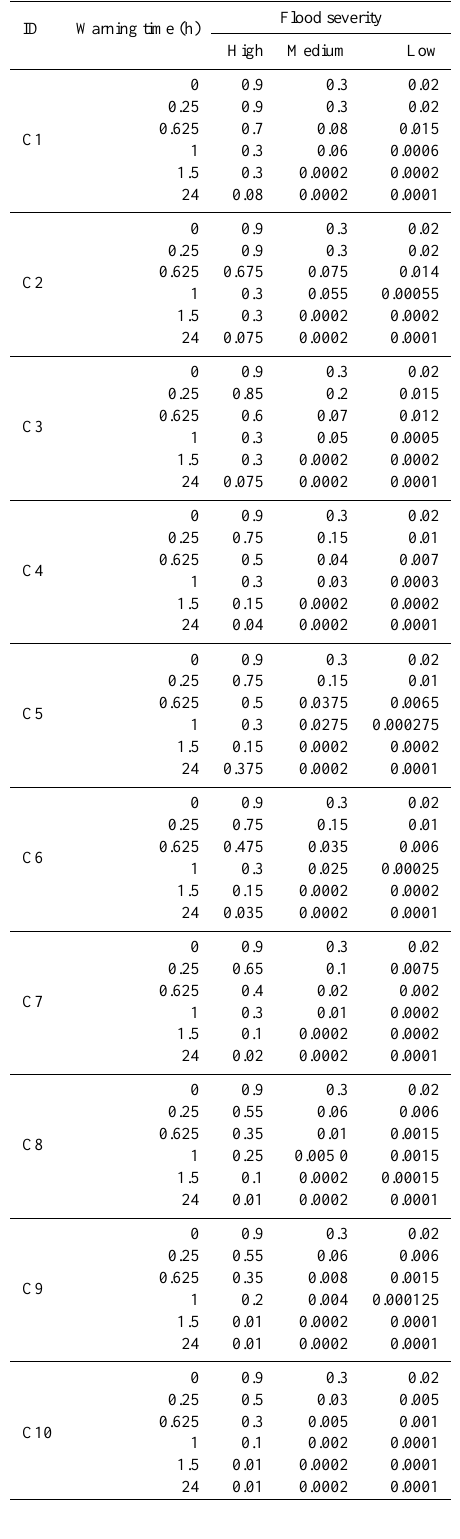
Table 2. Fatality rates in the case of river flooding (Escuder-Bueno et al.,